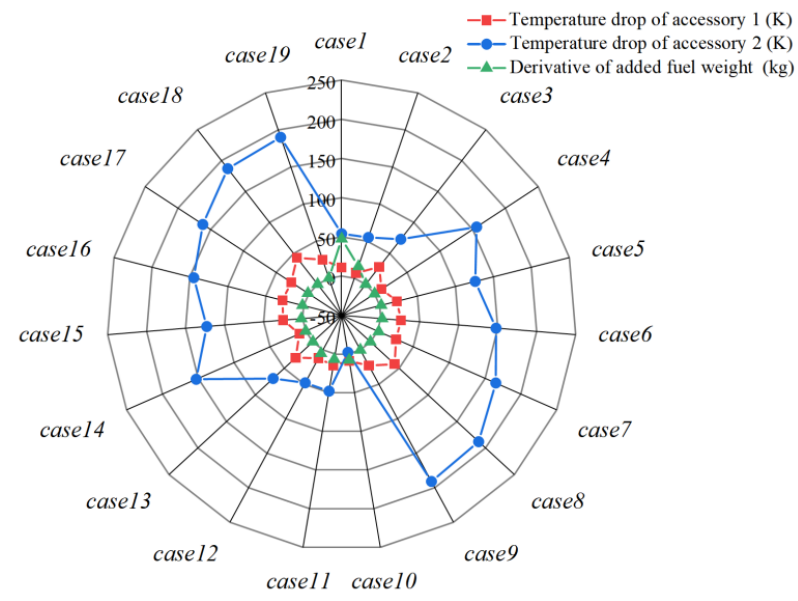
Figure 26. Thermal protection effect comparison of all cases.